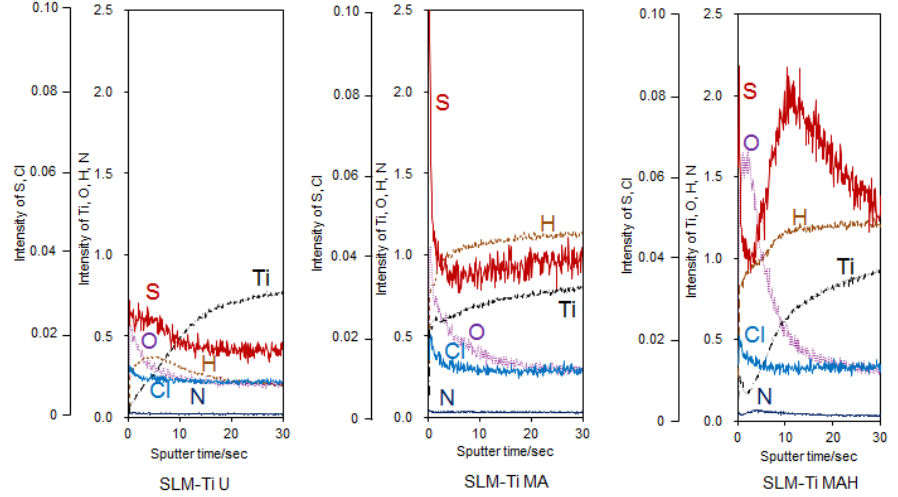
Figure 4. GD-OES profiles of SLM-Ti with or without the mixed acid and heat treatment. Measurement of the water contact angle revealed the hydrophobic nature of the cp-Ti metal surface at 92 ◦ . The contact angle was similar on SLM-Ti U (95 ◦ ) but significantly decreased to less than 1 degree on SLM-Ti MA and SLM-MAH, indicating the super hydrophilic nature of the chemically-activated